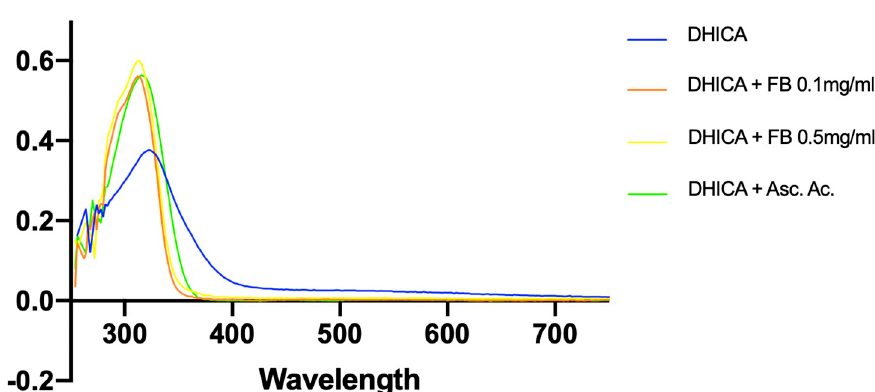
Figure 9. Effects of different antioxidant agents on the UV-VIS spectra of DHICA-melanin solutions 24 h after blue light irradiation. Data show the UV-VIS spectra of DHICA-melanin solutions treated with different antioxidant agents 24 h after blue light irradiation. DHICA-melanin solutions were irradiated together with FB (0.1 and 0.5 mg/mL) and ascorbic acid (2 mg/mL), and UV-visible spectra were measured 24 h after